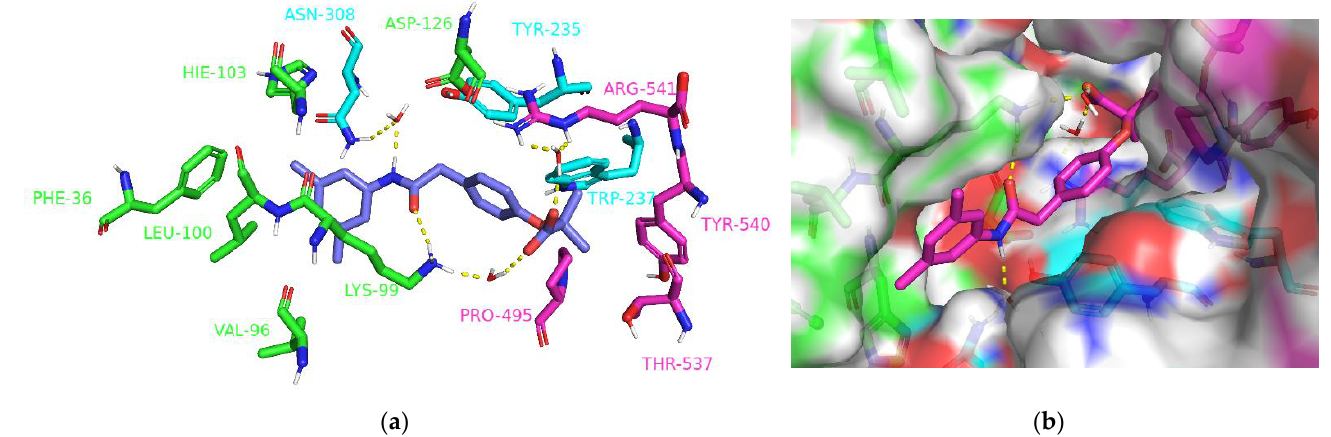
Figure 2. Binding mode of efaproxiral with deoxygenated hemoglobin (PDB:1G9V). ( a ) Intermolecular contacts of efaproxiral (purple) bound to deoxygenated hemoglobin in the complex. ( b ) The cavity binding diagram of efaproxiral (pink) with deoxygenated hemoglobin.